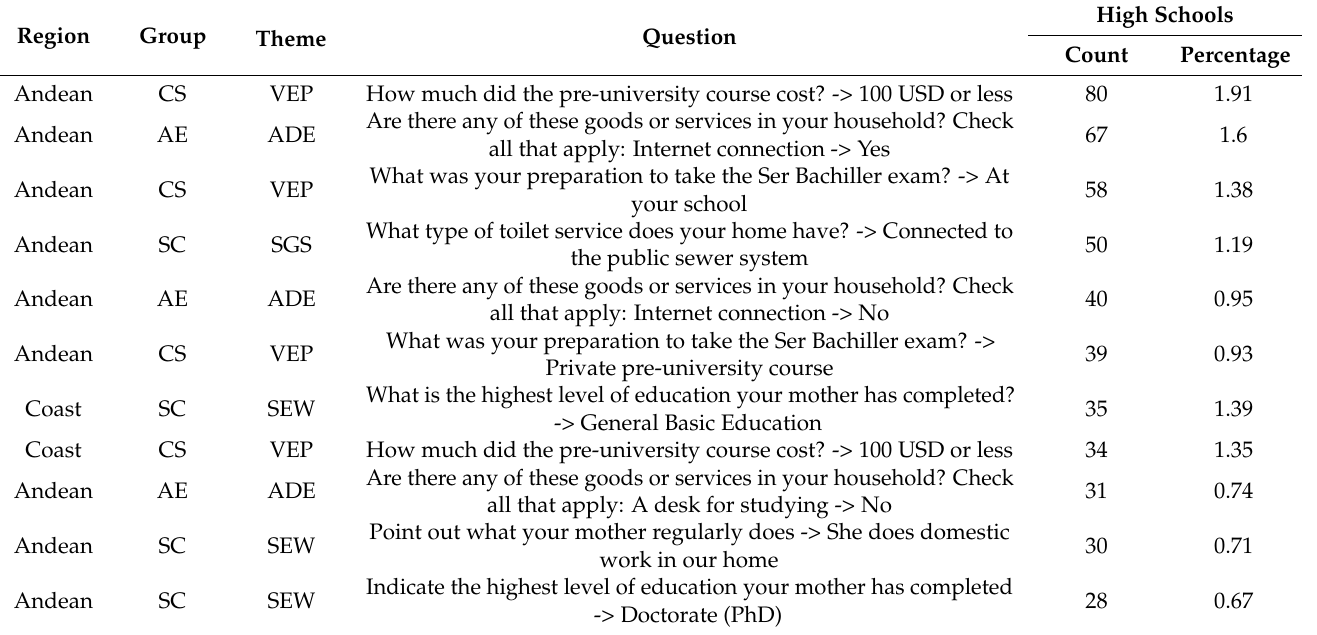
Figure A1. Example of the smoothing effect in the hot spot calculations using different kernel bandwidths: ( 1 ) one surrounding pixel (500 mts), ( 2 ) two surrounding pixels (1000 mts), ( 3 ) three surrounding pixels (1500 mts), ( 4 ) four surrounding pixels (2000 mts), and ( 5 ) five surrounding pixels (2500 mts). Table A1. Best predictive questions and answers for the high AP classification according to groups, themes, and regions. The questions are sorted by their respective counts.